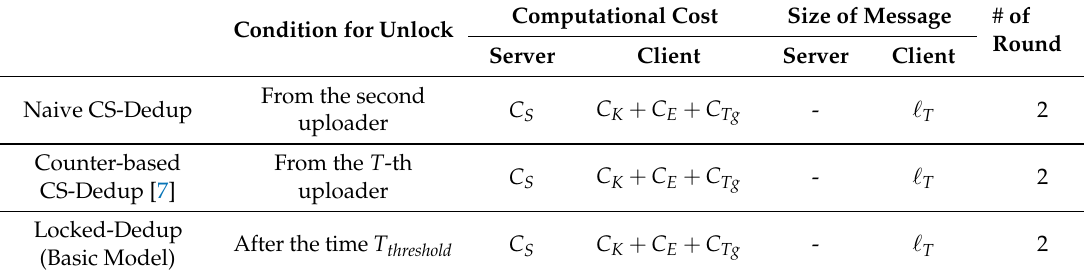
Table 2. Cost of the upload procedure for unlocked files.